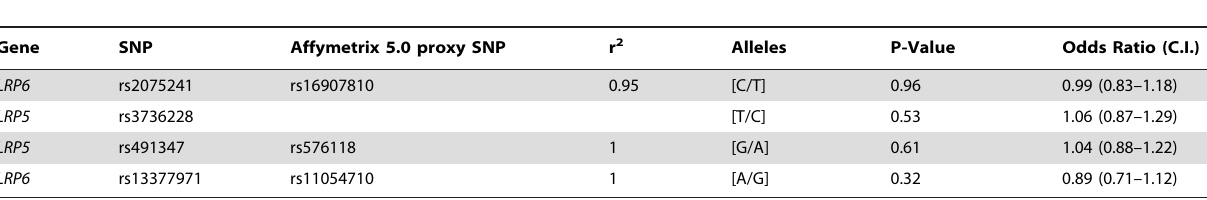
Table 3. Association analysis from the independent US Genetics of Kidneys in Diabetes study for the 4 most significant SNPs identified from this